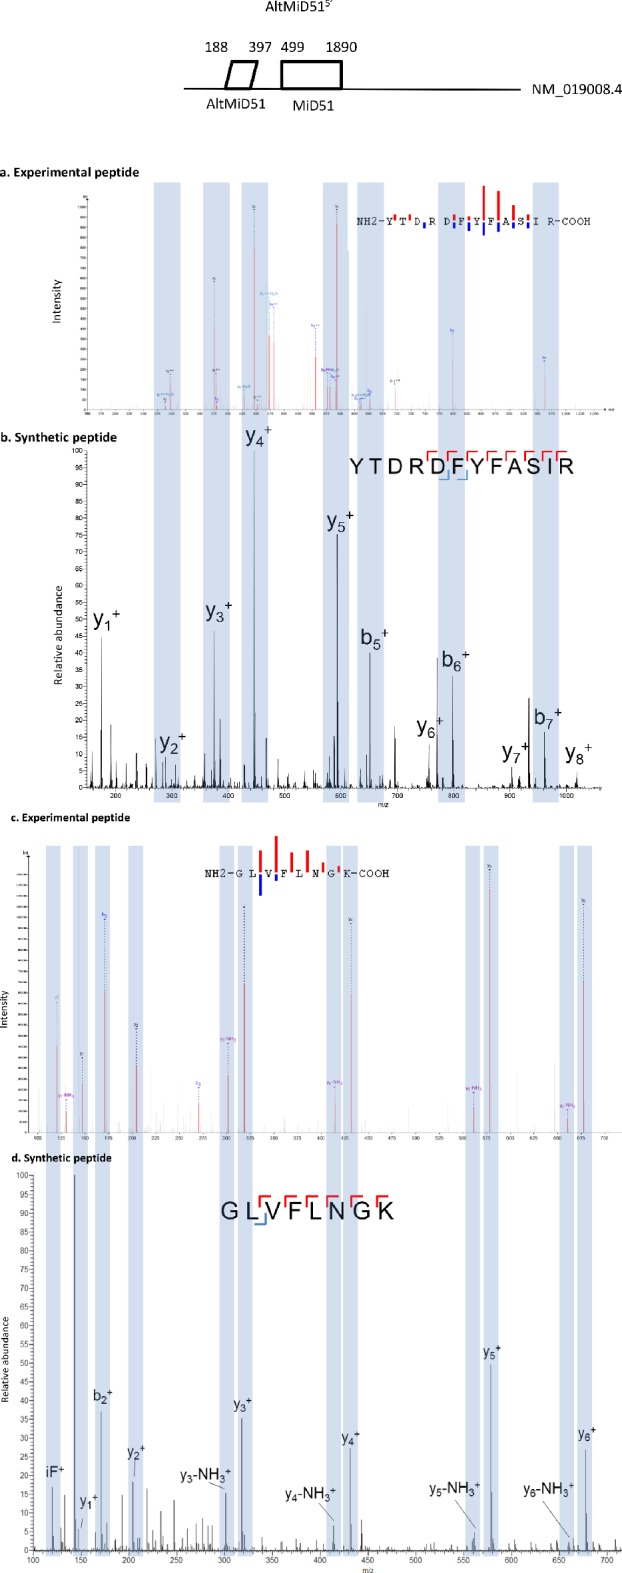
Spectra validation for altMiD51.Example of validation for altMiD51 specific peptides YTDRDFYFASIR and GLVFLNGK. (a,c) Experimental MS/MS spectra (PeptideShaker graphic interface output). (b,d) MS/MS spectra of the synthetic peptides. Matching peaks are shown with blue masks. A diagram of the transcript with its accession number and the localization of the altORF and the CDS is shown at the top.